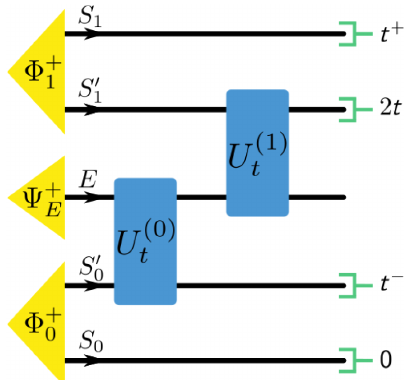
FIG. 29. Choi state for the shallow pocket model. Each wire of the Choi state of the shallow pocket model [defined in Eq. (217)] corresponds to a different time (where t − the input and output wire at time t 1 , respectively). The interme- diate system-environment unitaries U t are given by Eq. (216). Note that, in contrast to previously depicted Choi states, here, the environmental degree of freedom E is not traced out